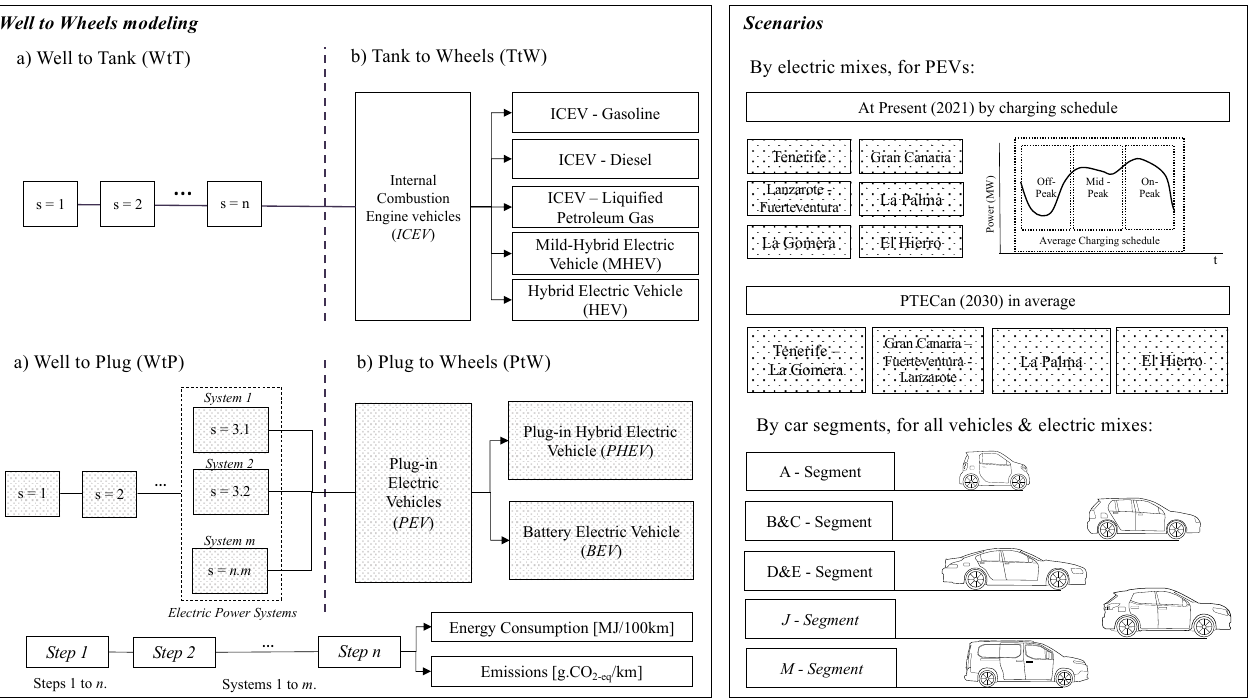
Figure 2. Modeling scheme.